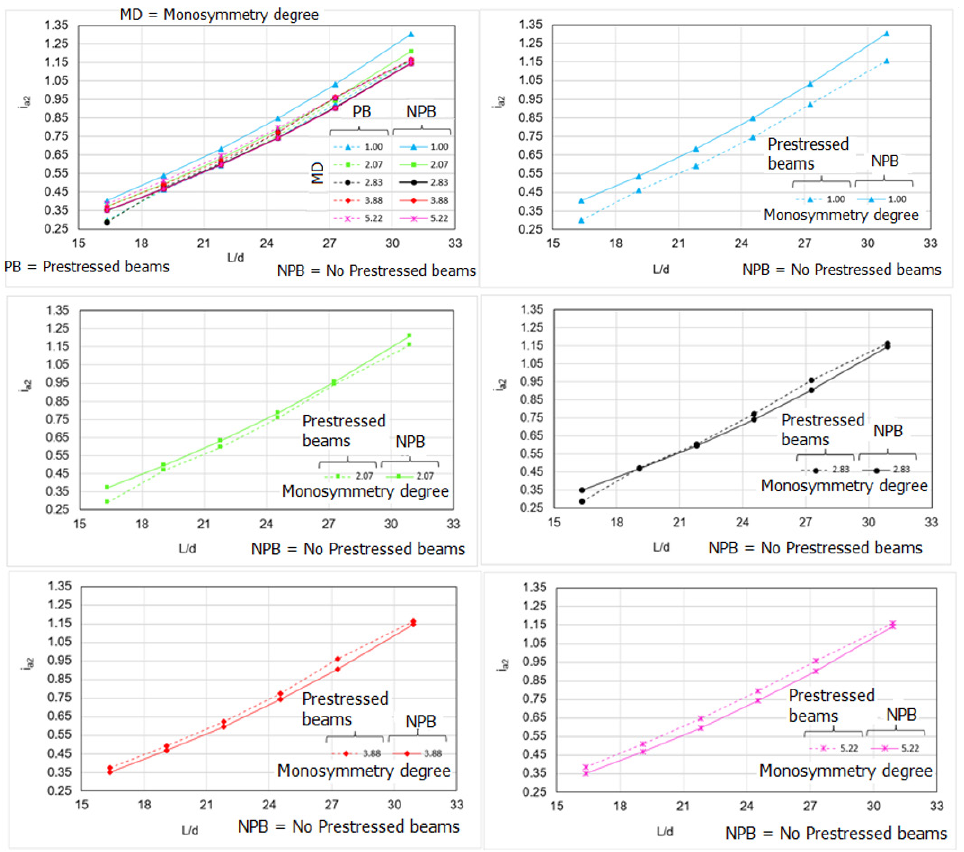
Figure 6. i a2 versus L/d ratio for e p =